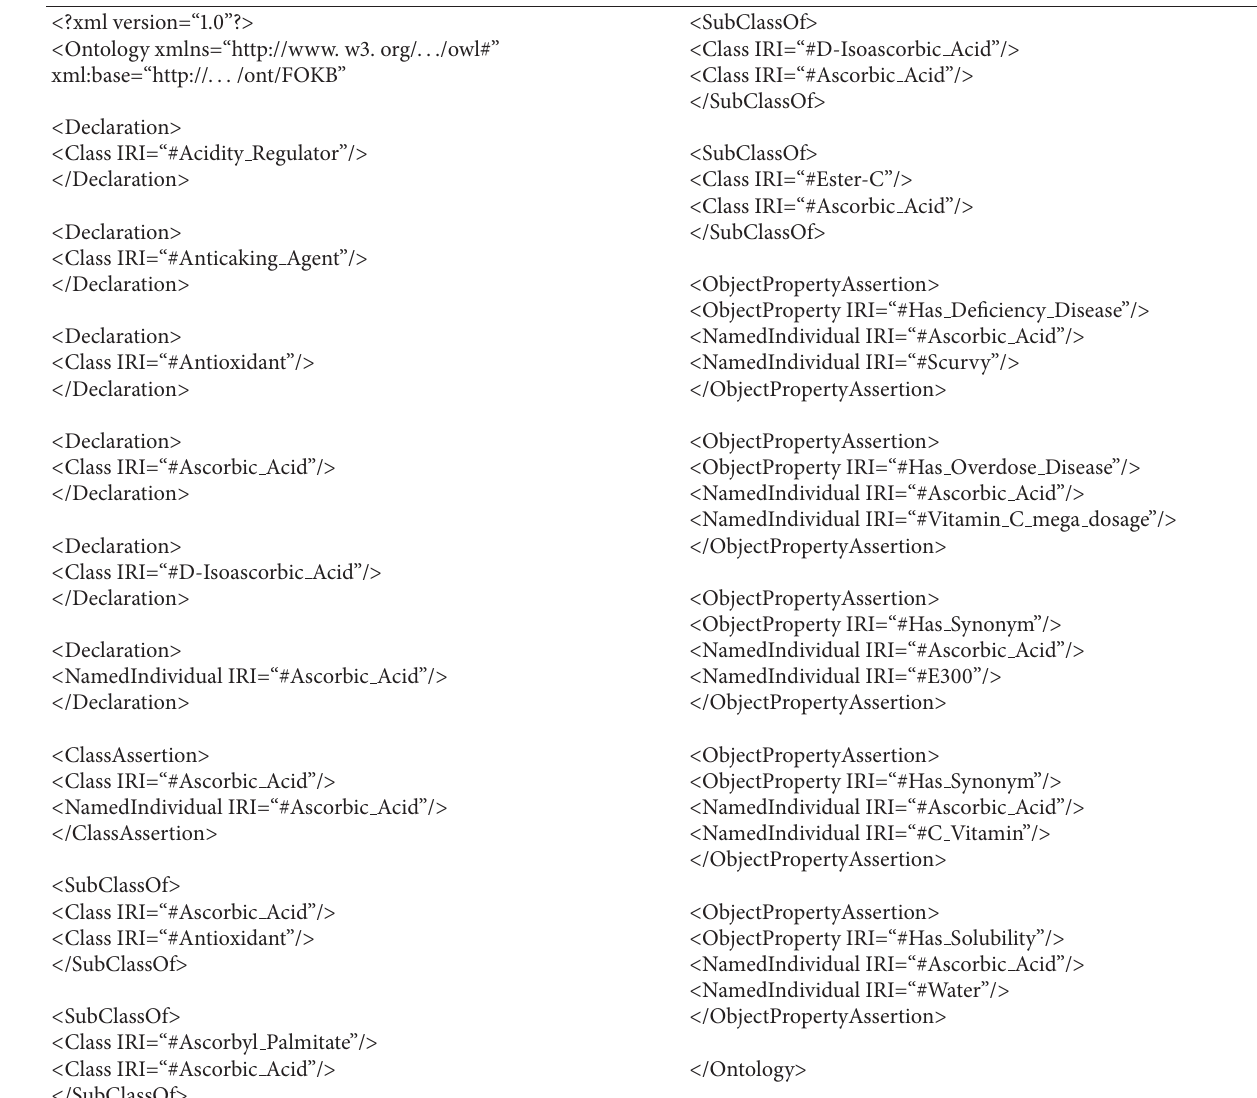
Table 9: OWL 2.0 syntax in food ontology knowledge base (FOKB) in the system.